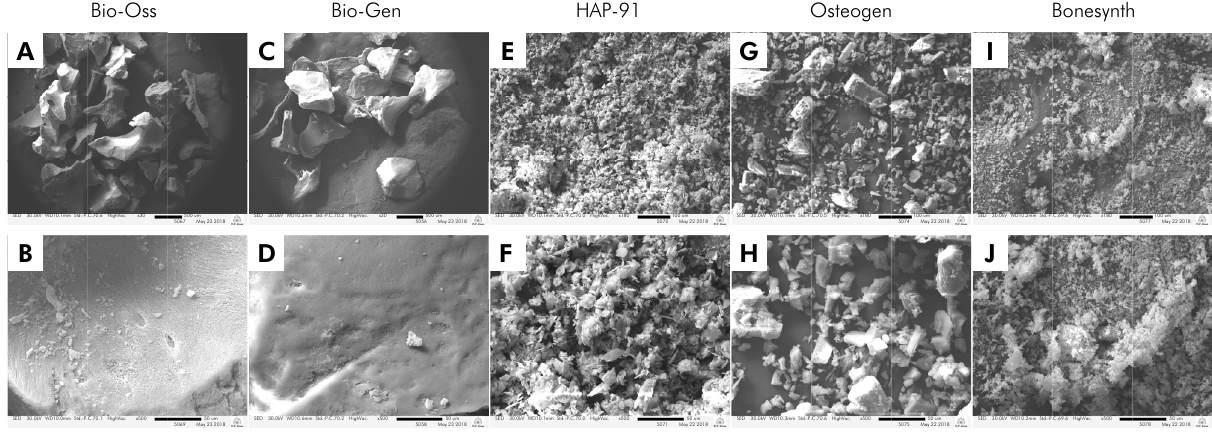
Figure 1. SEM analysis showing biomaterials morphology at 30x (a, c), 180x (e, g, i), and 500x (b, d, f, h, j) magnifications.